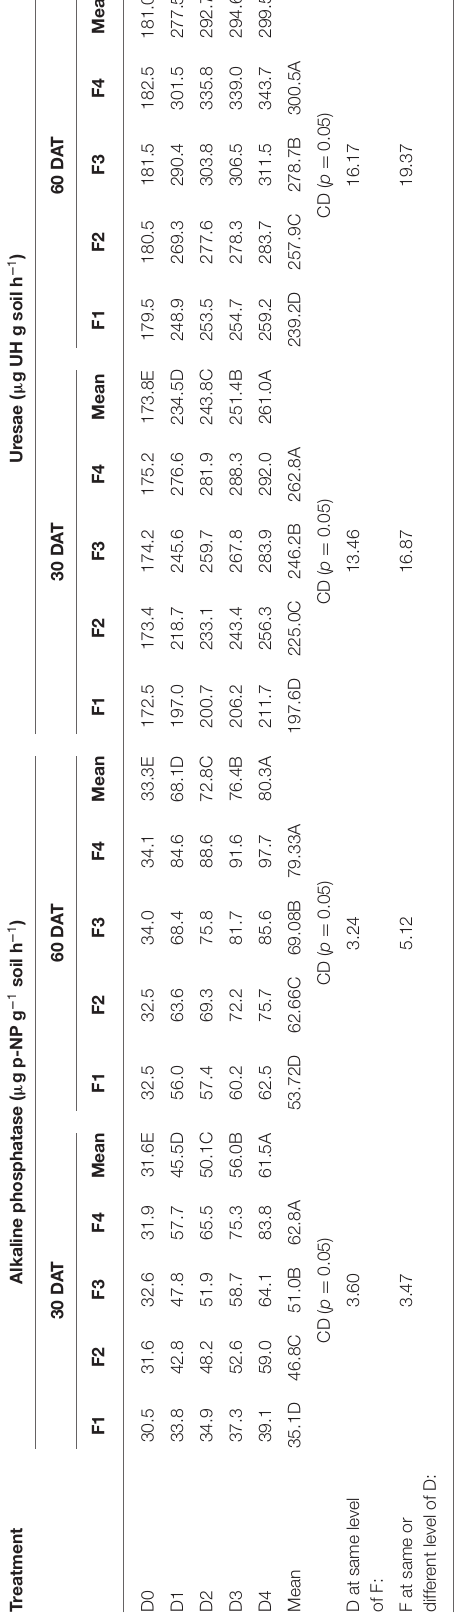
TABLE 10 | Energy equivalent of inputs and outputs. Particulars Units Equivalent